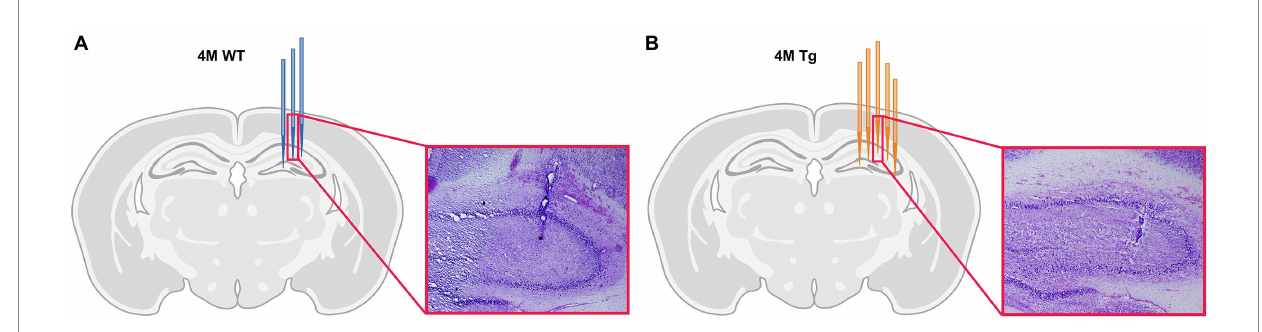
FIGURE 1 Histological validation of electrode position. (A) Schematic overview of electrode position in 4-month-old Wild type (WT) animals. Each blue electrode represents track of the electrode of a different WT subject. (B) Schematic overview of the electrode position in 4-month-old TgF344-AD (Tg) animals. Each orange electrode represents track of the electrode of a different Tg subject. The red insert shows exemplary light microscopy images of Nissl- stained brain slices showing the electrode trace in the hippocampus of a WT animal (A) and TgF344-AD rat (B)